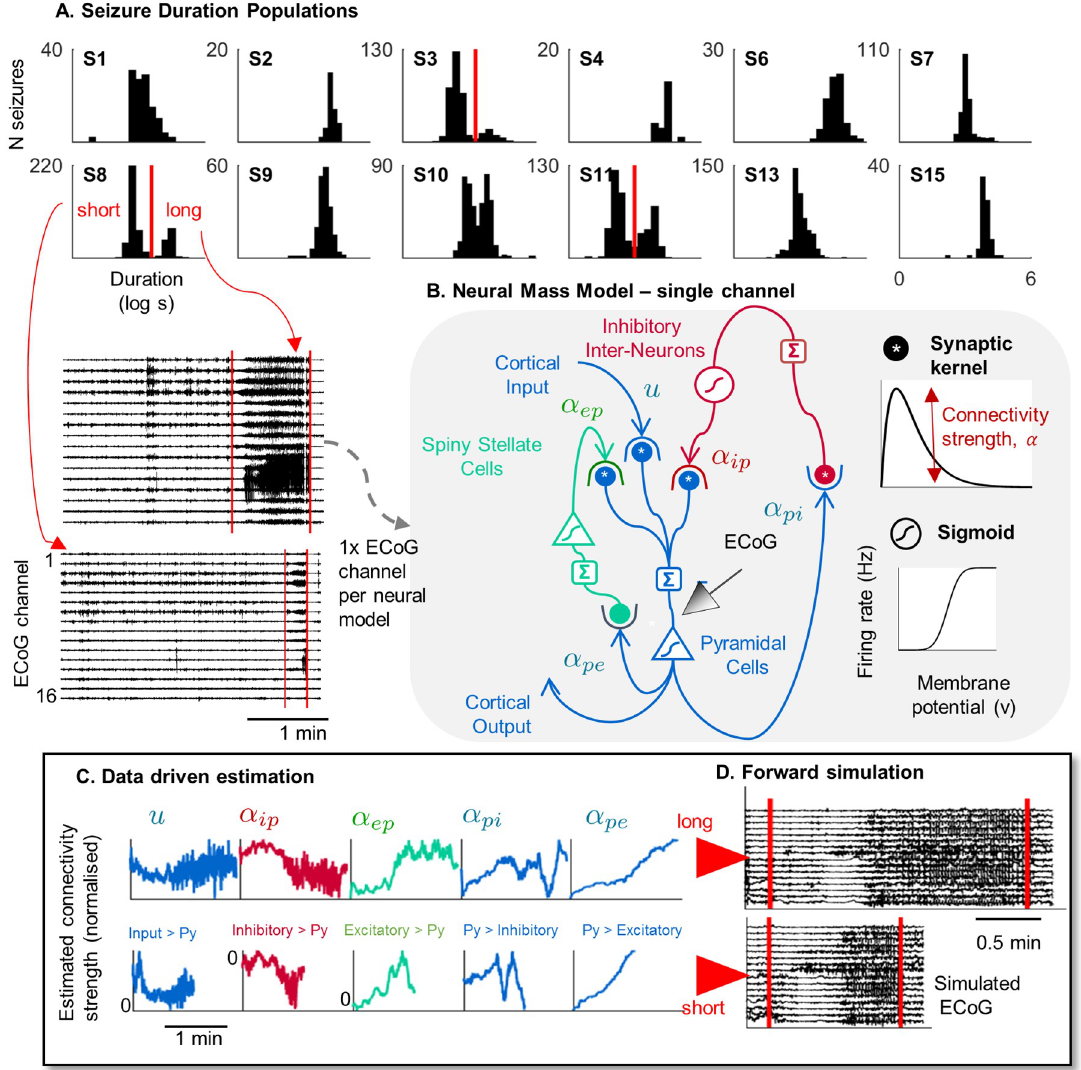
Fig 1. Data driven estimation using a neural mass model. A . Histograms of seizure durations (log seconds) for the twelve patients considered in this study, with examples of ECoG during a long and short seizure from a single patient, S8. B . Schematic of the neural model. Each synapse is defined by a convolution kernel (converting pre-synaptic firing rates to post-synaptic membrane potentials). Each population is defined by a sigmoid function (converting mean membrane potential to average firing rate). C . Example estimation time series of the five connectivity parameters during a long and short seizure for one patient. D . Deterministic forward simulation using the estimated parameters in C (red lines mark actual seizure onset and